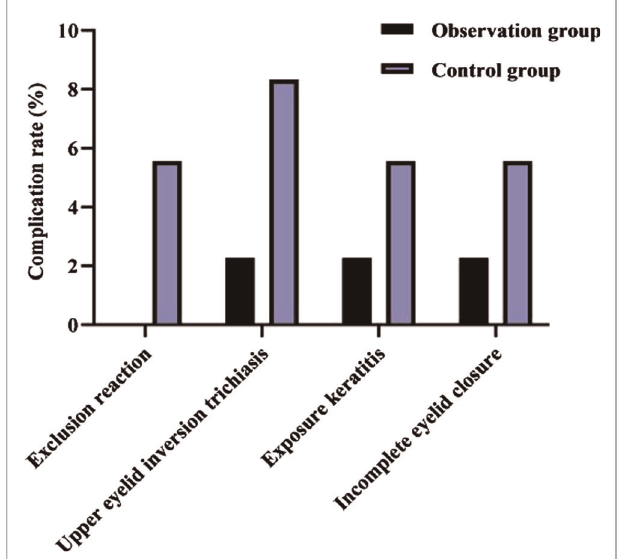
FIGURE 5 | Comparison of postoperative complication rates between two groups (n,